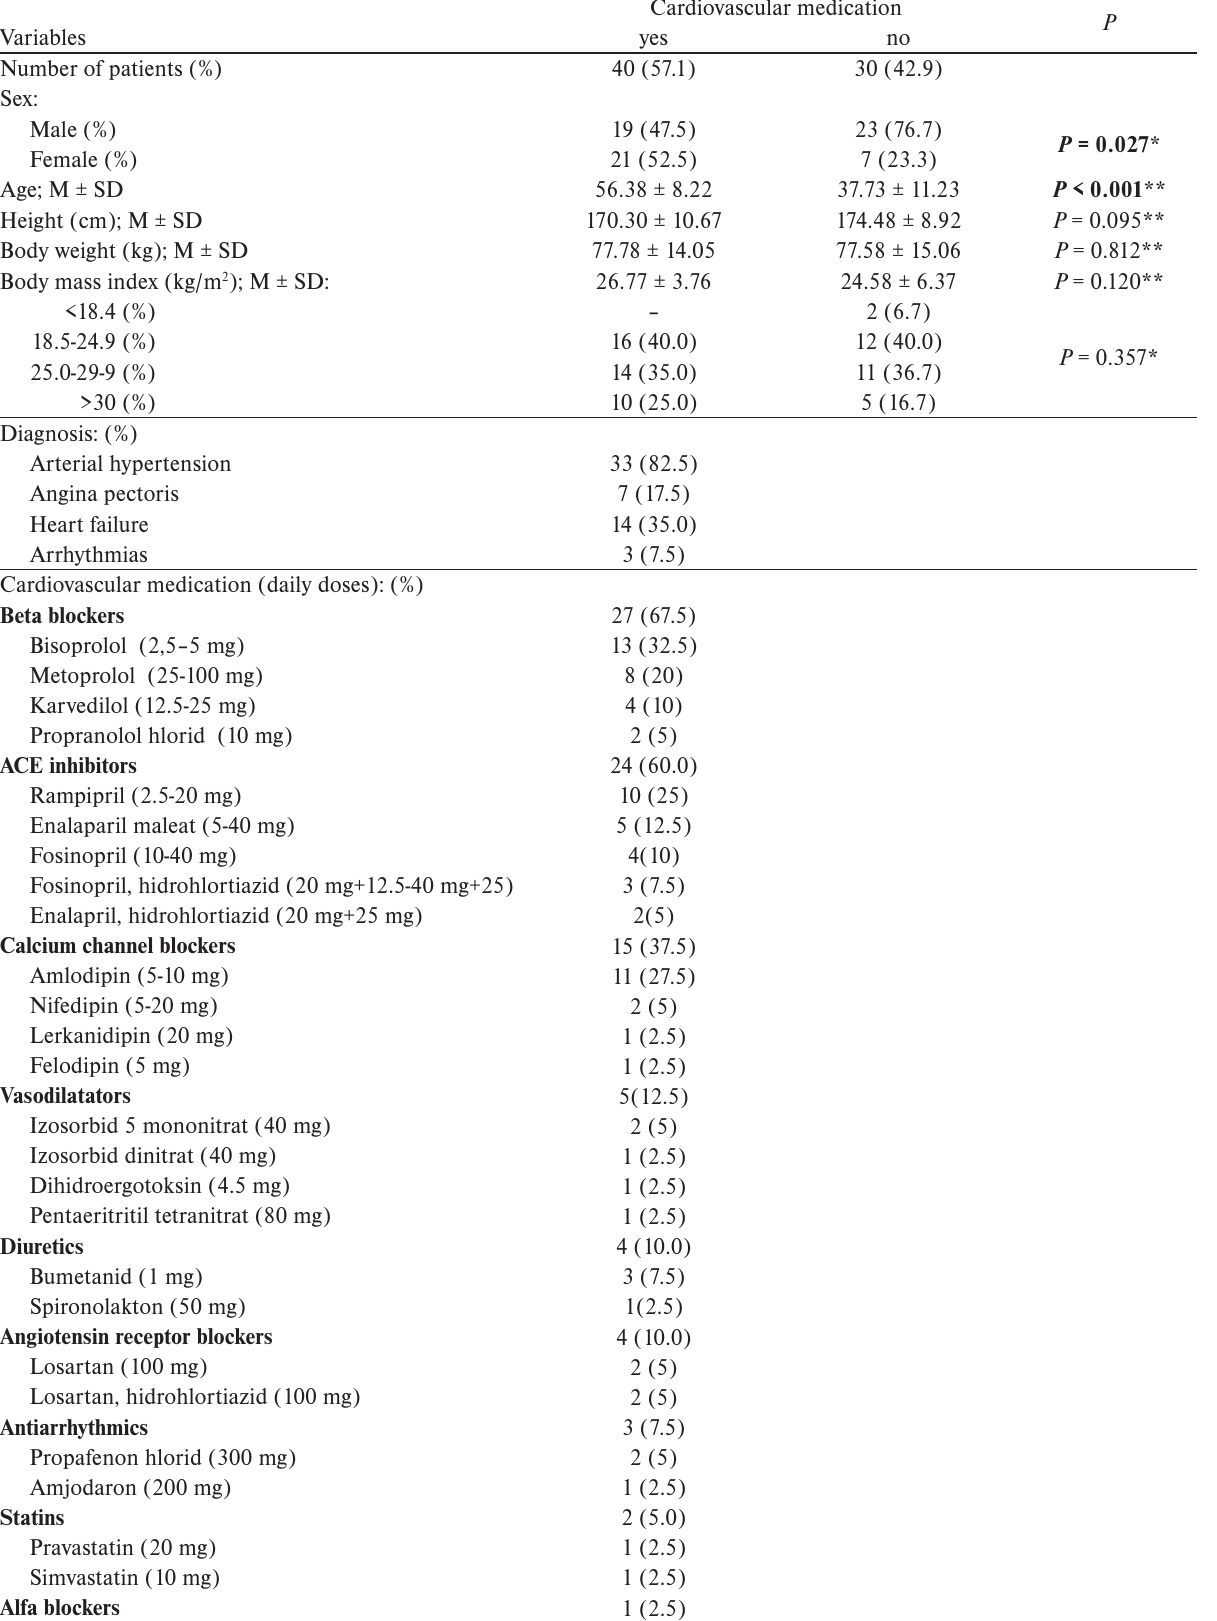
Table 1. Socio-demographic characteristics of the study patients: the patients treated chronically by cardiovascular drugs; the patients without cardiovascular